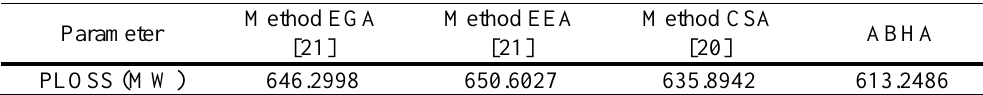
Table 12. Comparison of real power